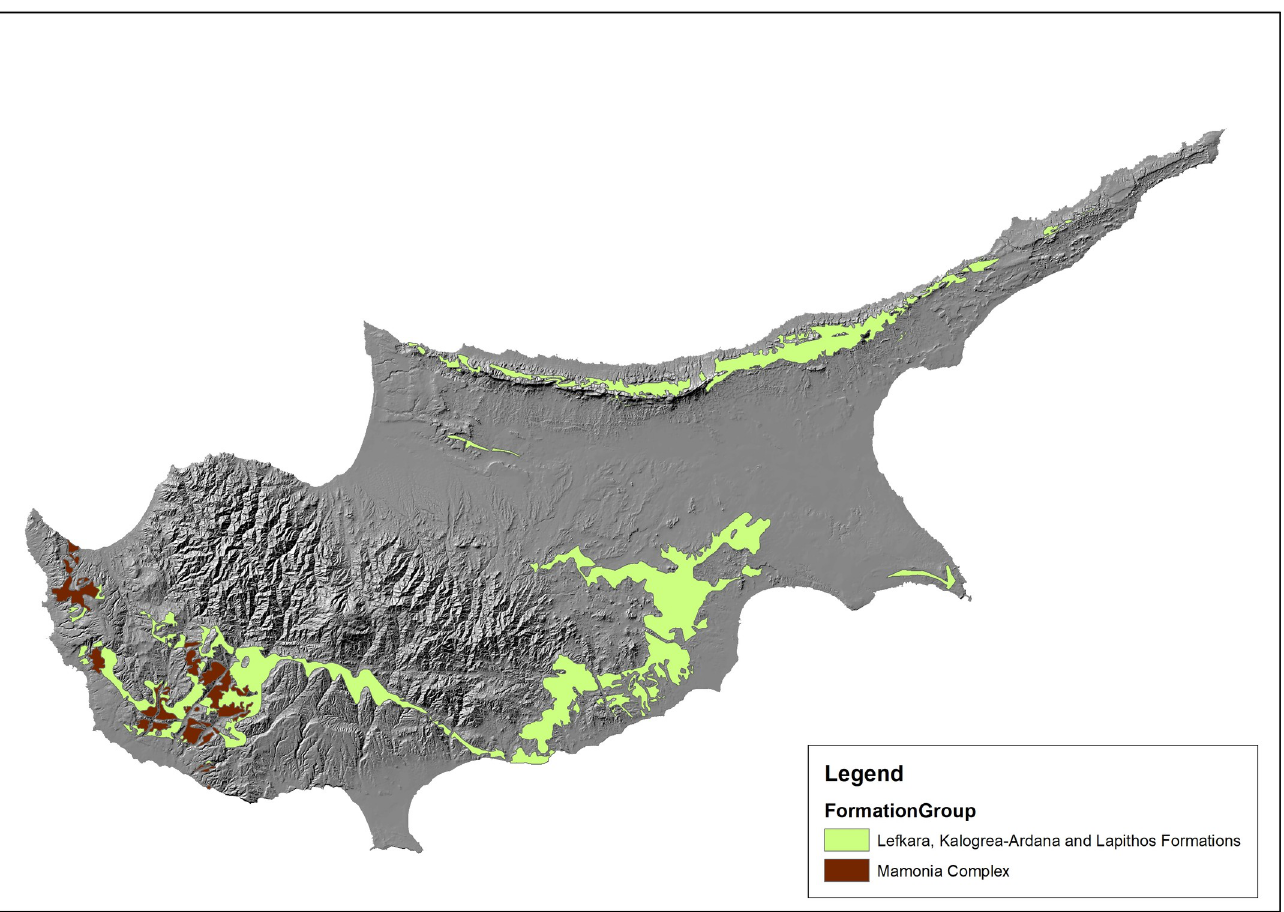
Fig 7. Chert-bearing geological formations of Cyprus. Original copyright with the